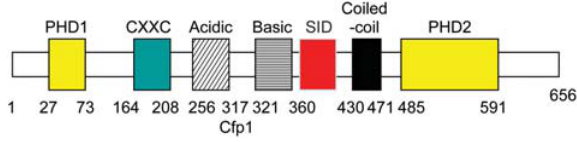
Figure 1 Schematic representation of the domain structure of Cfp1. Numbers refer to amino acid residue positions. PHD, plant homeo- domain; CXXC, DNA-binding domain; SID, Setd1 interaction